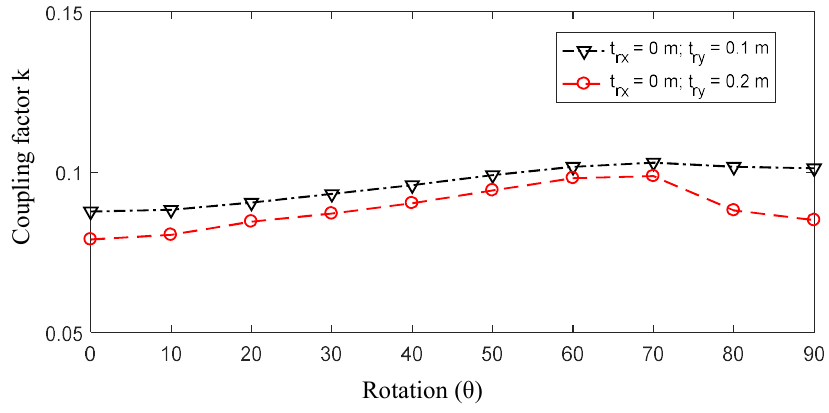
Figure 7. Coupling factor k vs. coil rotation θ .